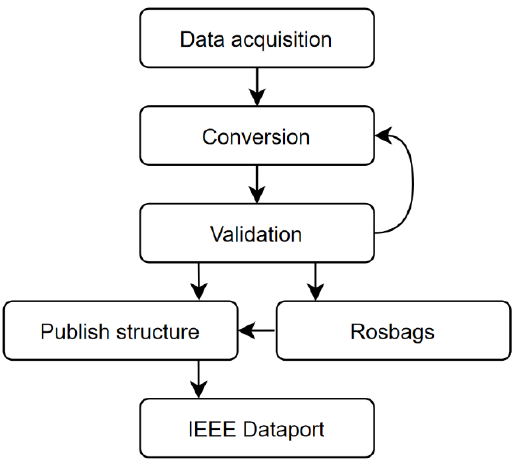
Fig. 4. File formats used during dataset